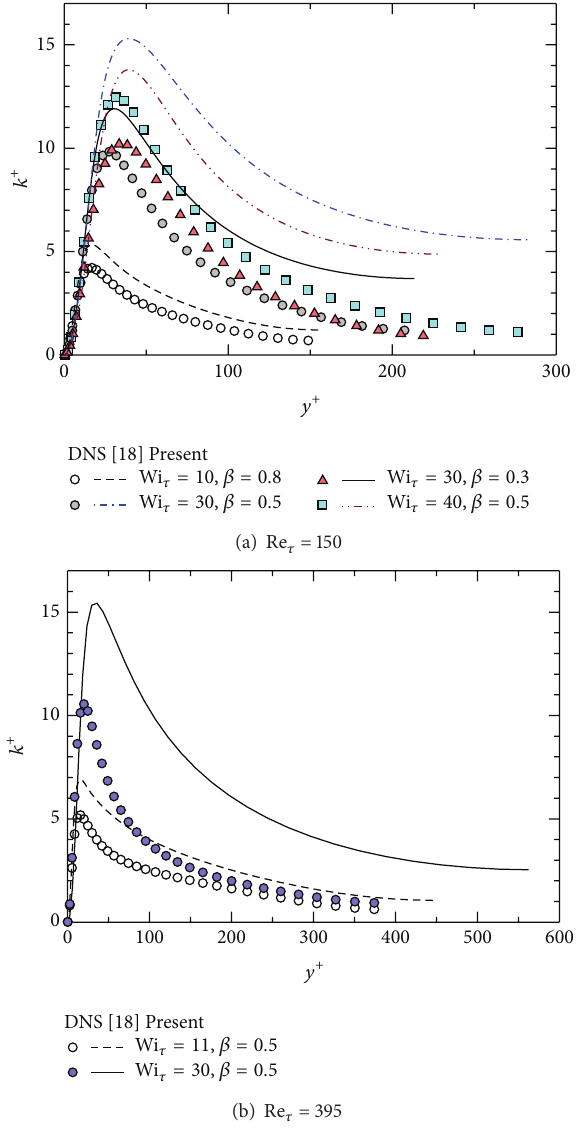
Figure 9: Same with Figure 6, but with respect to turbulent kinetic energy, 𝑘 +